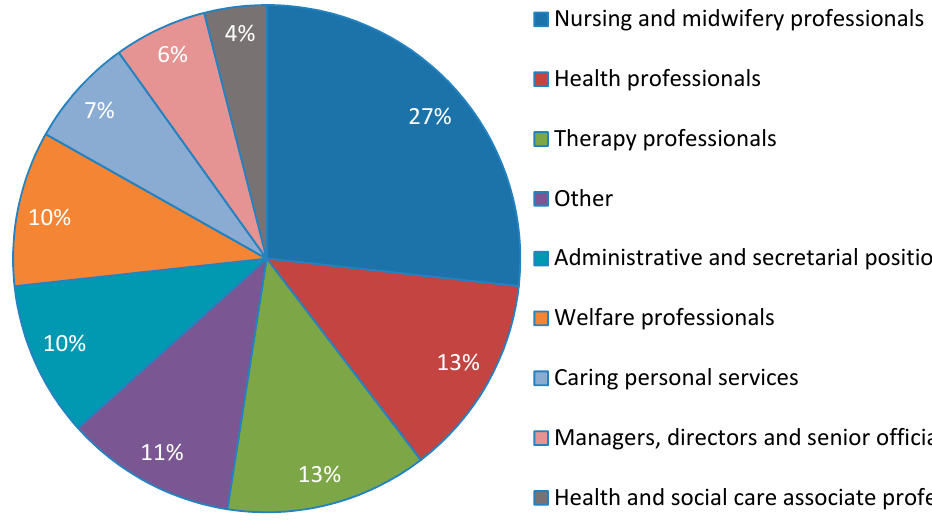
Figure 1. Occupations of health and social care respondents.